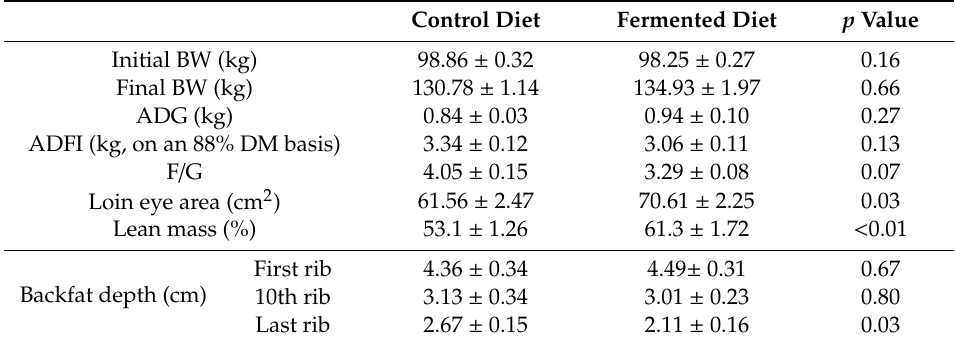
Table 4. Diets e ff ect on the growth performance and carcass traits in finishing